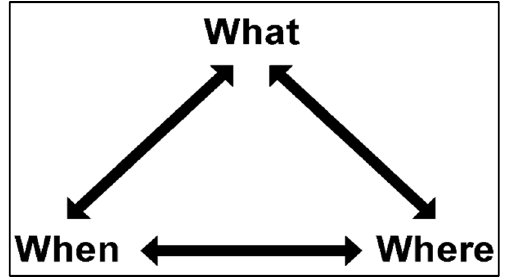
Figure 8. Basic components of the Triad framework”[86].